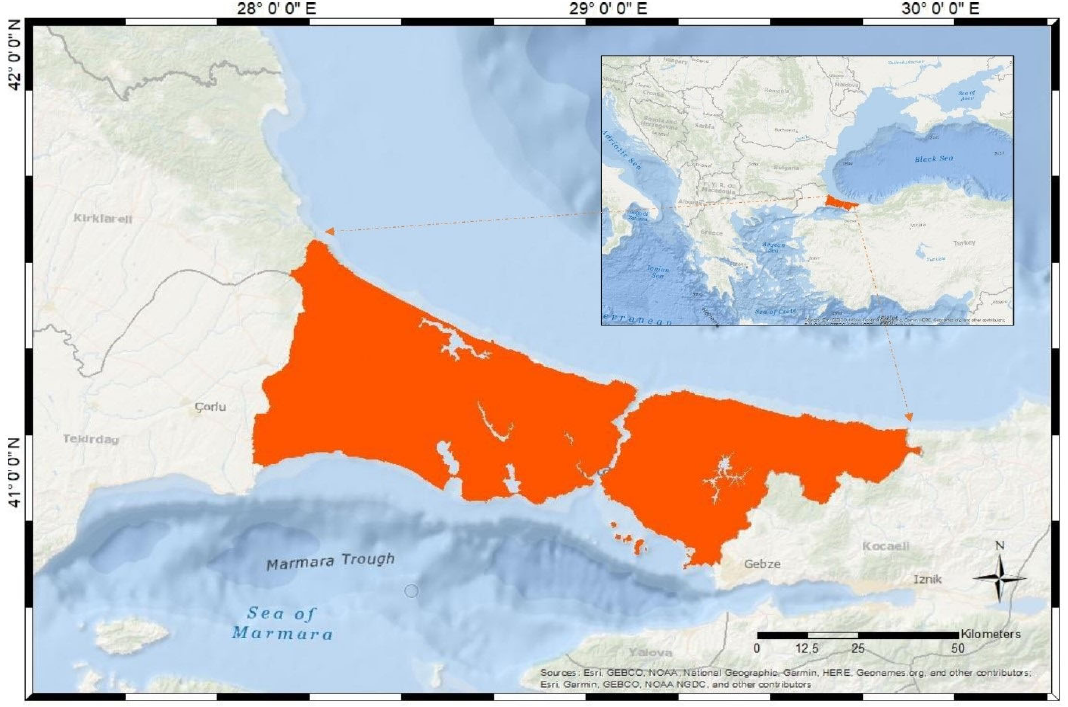
Figure 1. The map of the study area (Istanbul metropolitan area).